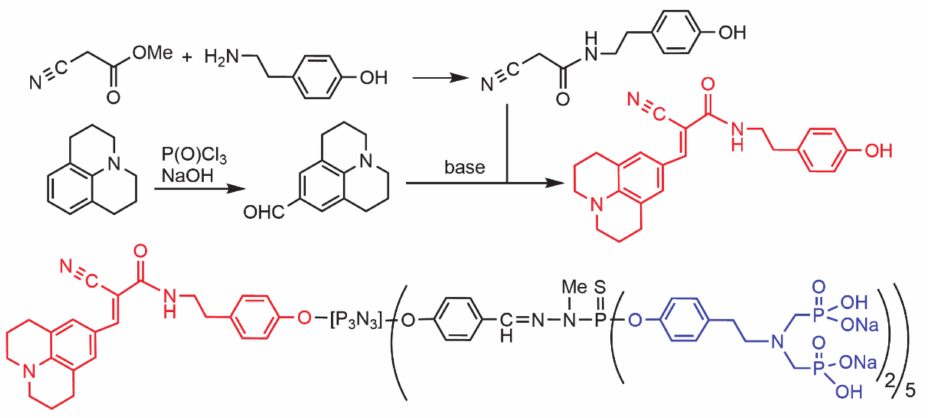
Figure 8. Synthesis of a julolidine derivative, and its use for the functionalization of an azabisphos- phonate